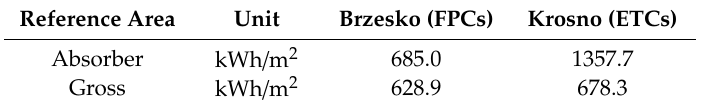
Table 3. Solar heat gain values coming from installations in Brzesko (FPCs) and Krosno (ETCs) obtained in the whole analyzed period (from 1 August 2013 to 31 July 2015) in reference to various area types.